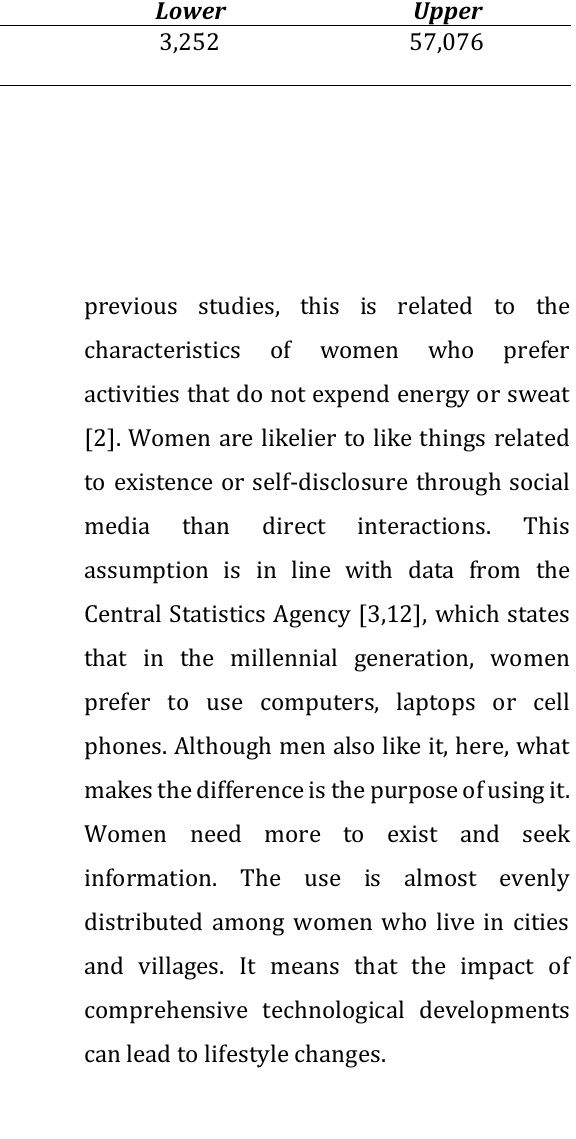
Risk Estimate of Sociodemographic Factors on Lifestyle Value 95% Confidence Interval Odds Ratio for the